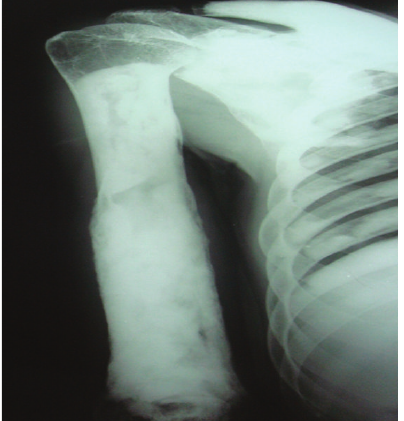
Figure 11: Radiograph of the humerus showing osteosclerosis of the humerus and scapula and typical “funnel-like appearance” (Erlenmeyer-flask deformity) in the humerus.